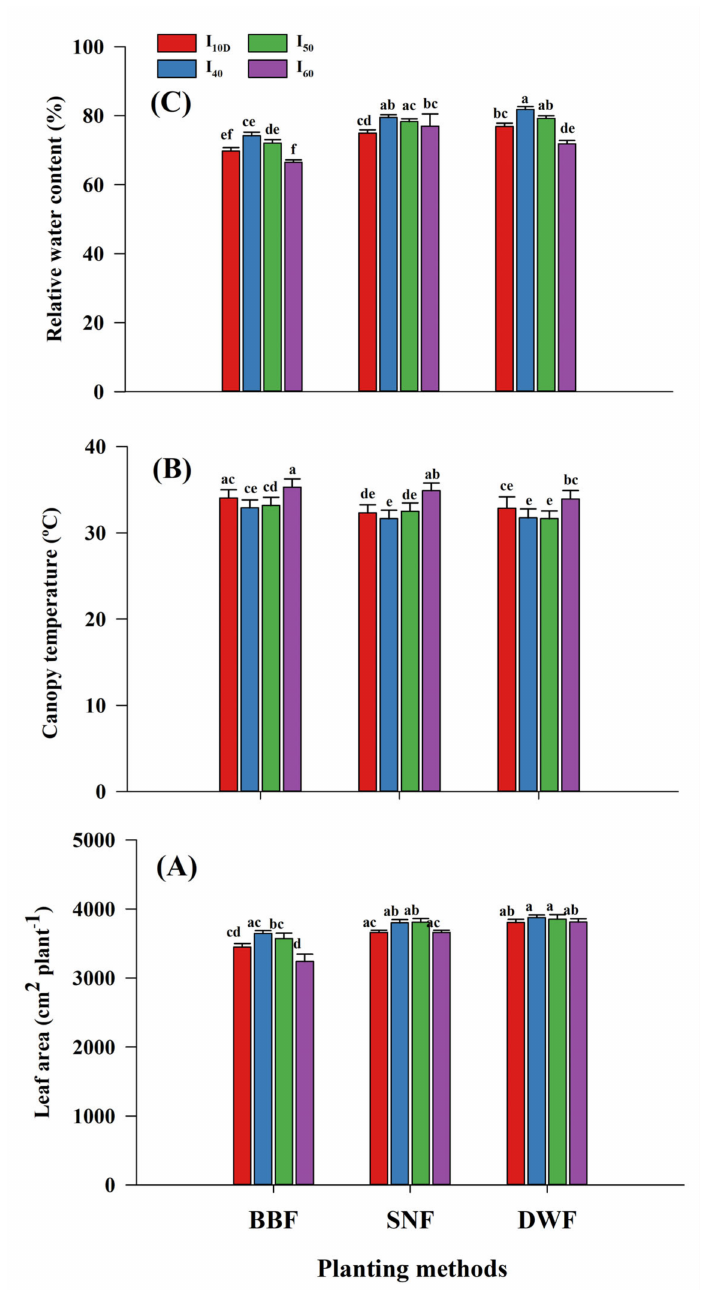
Figure 1. Influence of planting methods and irrigation levels on leaf area ( A ), canopy temperature ( B ) and relative water content ( C ) of maize at 90 DAS. Means followed by the same letter (s) within a bar are not significantly